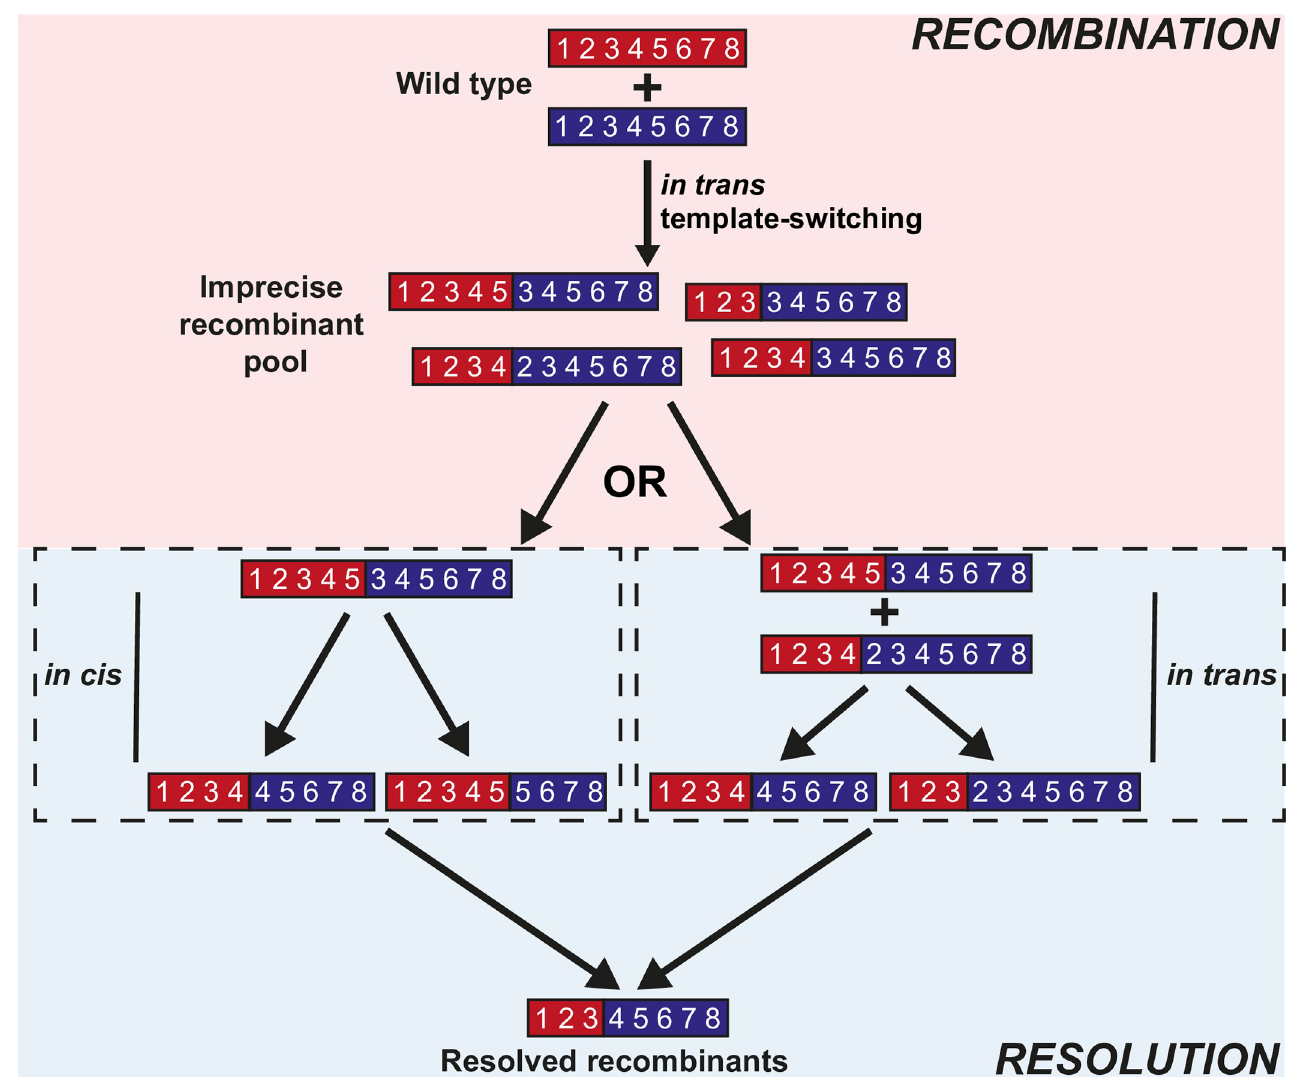
Fig 1. Model of recombination and resolution. Recombination initially occurs as an in trans template-switching event between two parental viruses (represented by numerical genome schematics). This event generates a mixed population of viruses containing a variety of imprecise recombinants with sequence duplications, as represented by the duplicated numbers of the schematic genomes. The pool of imprecise recombinants subsequently undergoes resolution where these duplications may be lost via an, as yet undetermined, in cis deletion process or via further rounds of in trans template-switching recombination